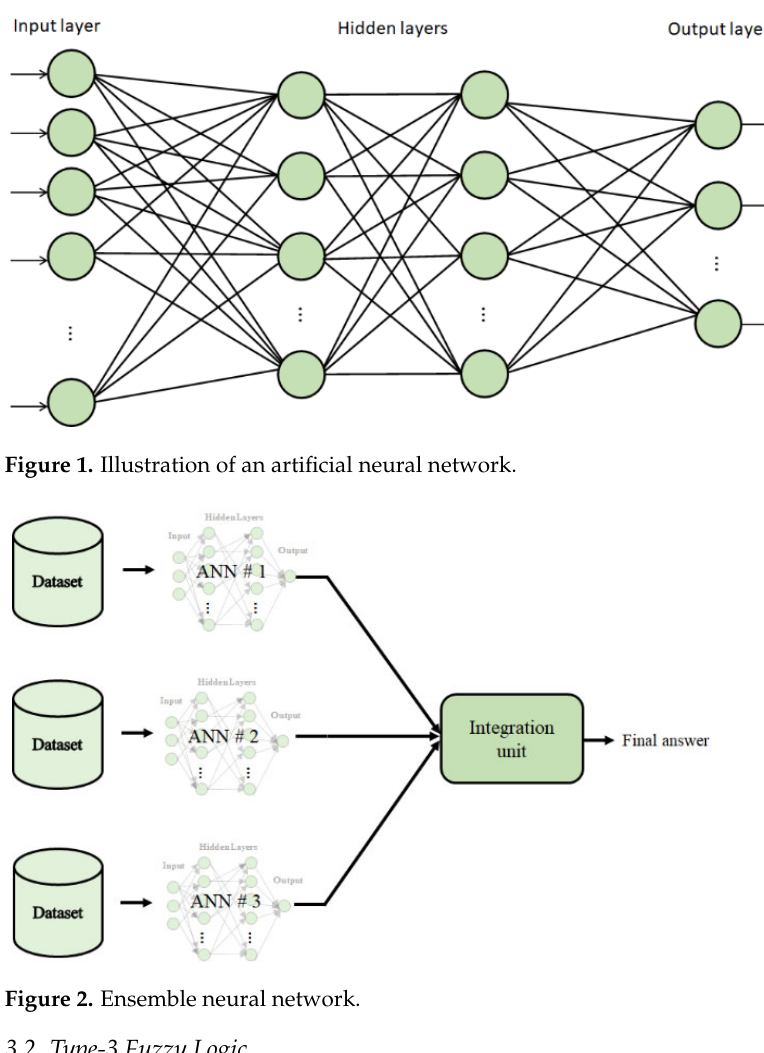
Figure 1. Illustration of an artificial neural network.